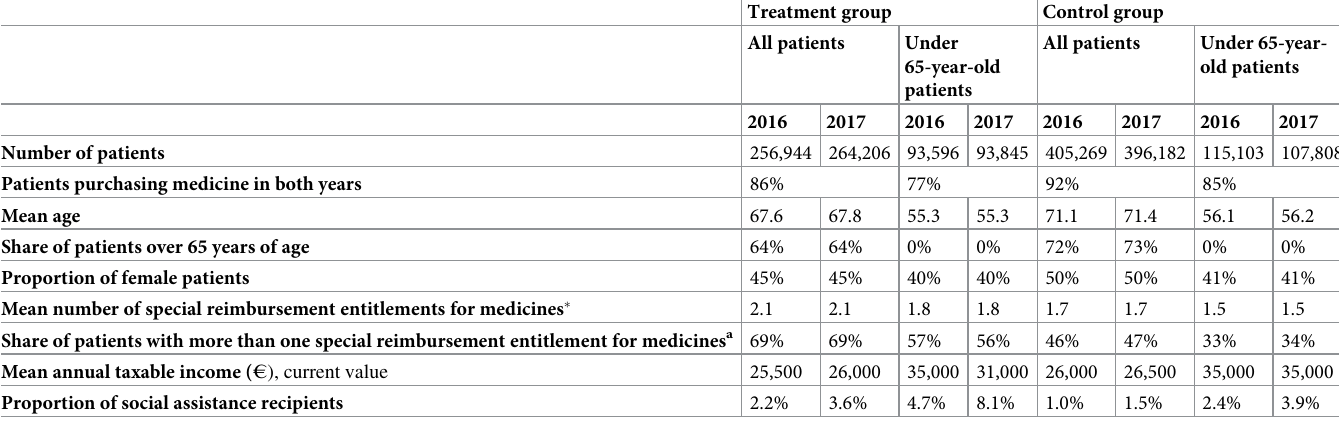
Table 1. Patient characteristics in type 2 diabetes patients (‘treatment group’) and chronic hypertension or hyperlipidemia patients (‘control